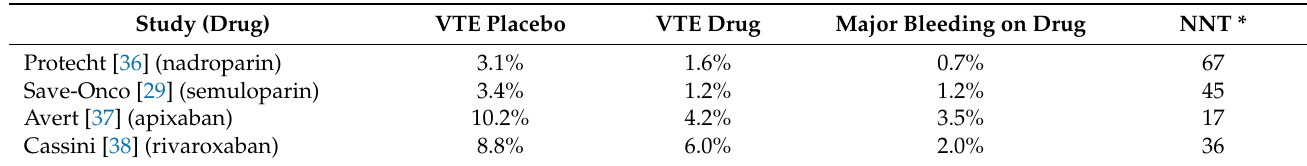
Table 8. Studies on pharmacological thromboprophylaxis for VTE in cancer